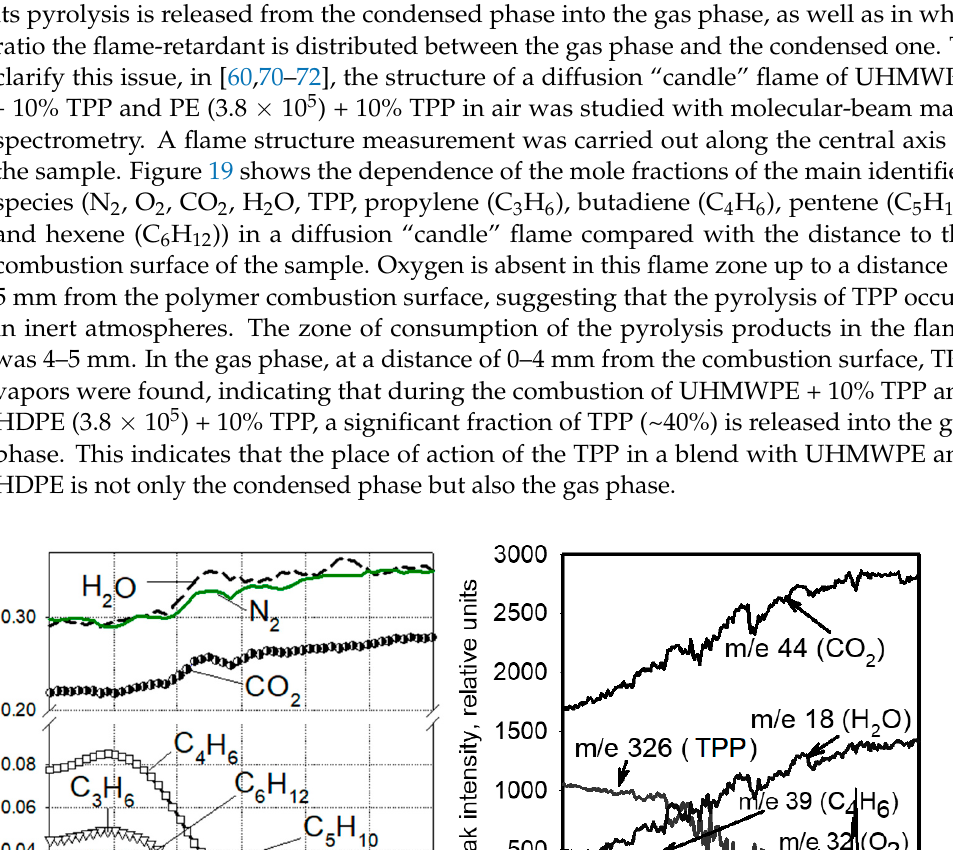
Figure 18. Temperature profiles in the diffusion flames of UHMWPE (solid curve) and UHMWPE + 10% TPP (dashed curve) in air.